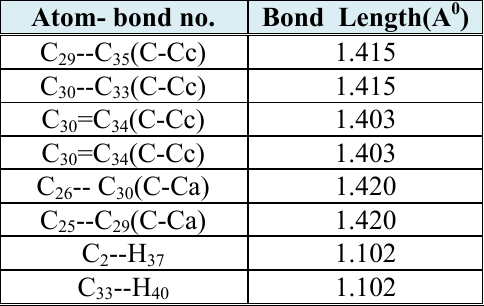
Table 3: The calculated bond distances of a zigzag CNT (9,0) by Gaussian 03. Atom- bond